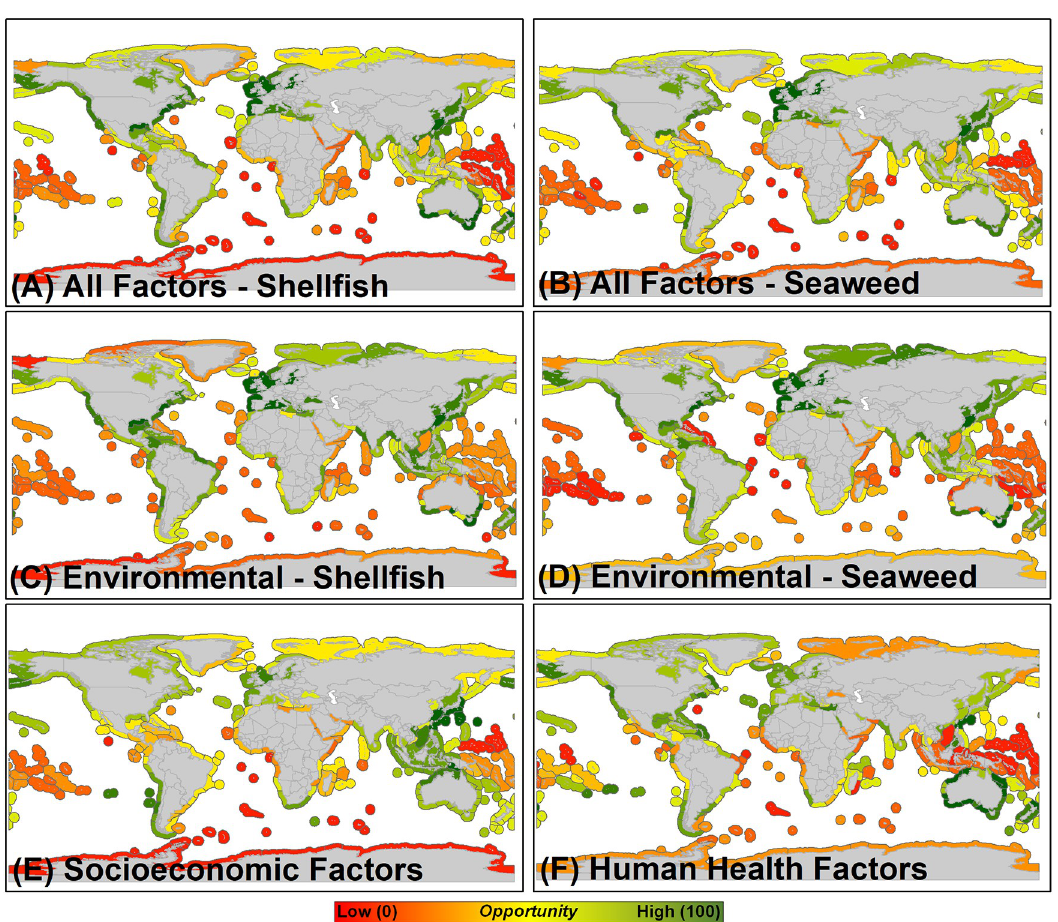
Fig 4. High (green) to low (red) opportunity marine ecoregions for development of (A) shellfish aquaculture and (B) seaweed aquaculture based on the synthesis of all environmental, socioeconomic, and human health factors (Table 1) according to their assigned weights (Table 2) within the restorative aquaculture opportunity index. High opportunity marine ecoregions based on the synthesis of all environmental factors only (C) and (D), socioeconomic factors only (E), and human health factors only (F) according to their assigned